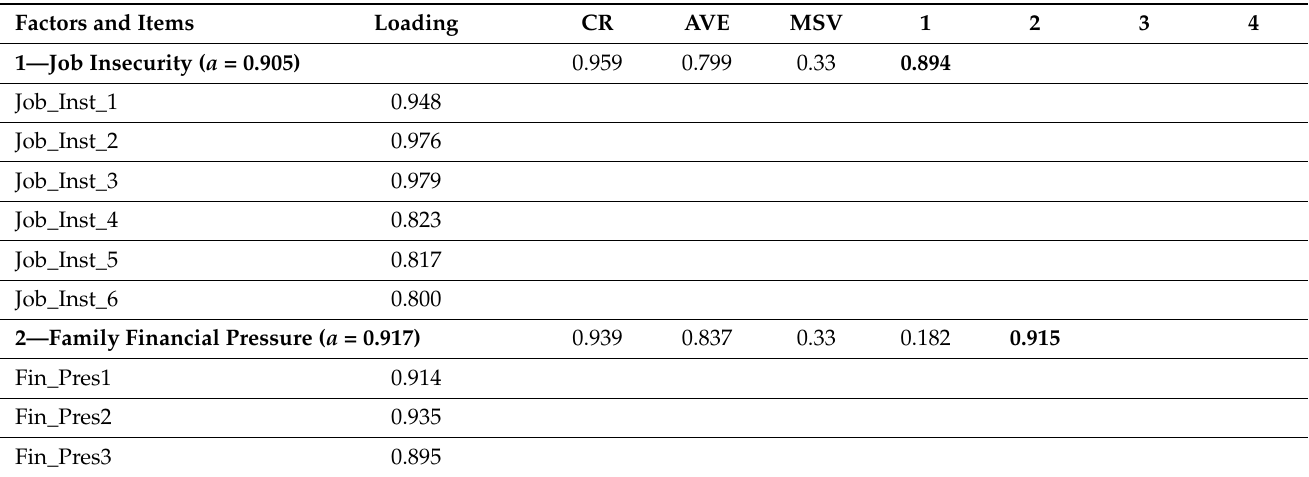
Table 2. CFA Discriminant and Convergent